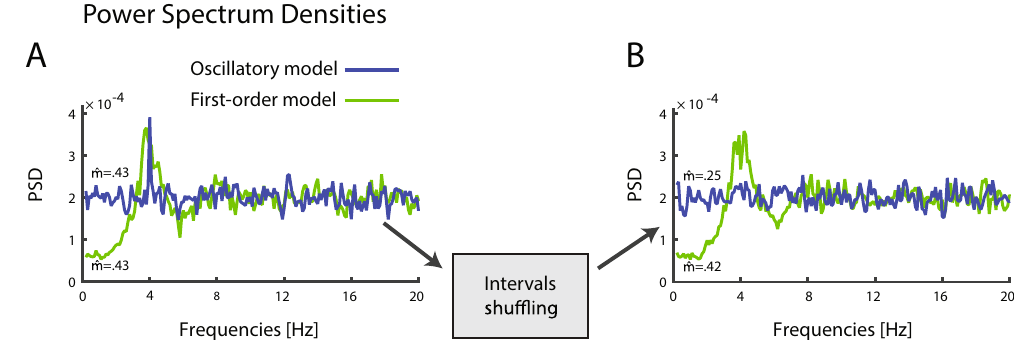
Figure 6. Modulation of the power spectra by shuffling. ( A ) Spectra of oscillatory model and first-order model matched in spectral peak magnitude. ( B ) After shuffling, the spectrum of the oscillatory model is flattened while the spectrum of the first-order model is